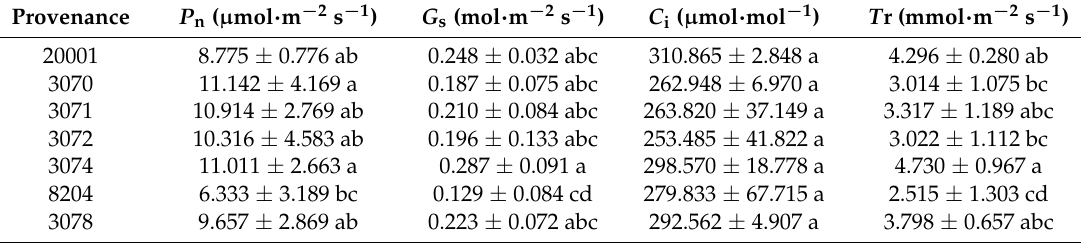
Table 7. Values of gas exchange parameters among teak clones from different provenances. Provenance